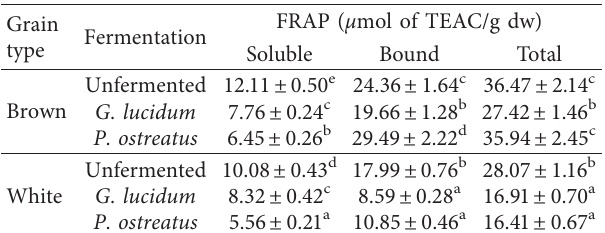
Figure 6: Changes in HPLC patterns of white teff phenolic compounds (bound fraction) due to mushroom mycelium-mediated solid-state fermentation. (a) Matched control (unfermented); (b) G . lucidum (KACC 42231); (c) P . ostreatus (KACC 42738). Table 3: Changes in FRAP of teff grain during mushroom mycelia- mediated solid-state